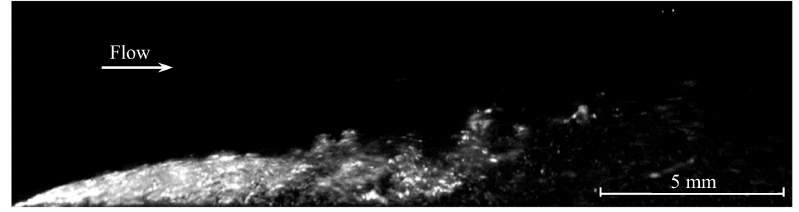
Figure 4. A typical snapshot showing the instantaneous cavity shape ( σ = 2.38, u in = 9.33 m / s).